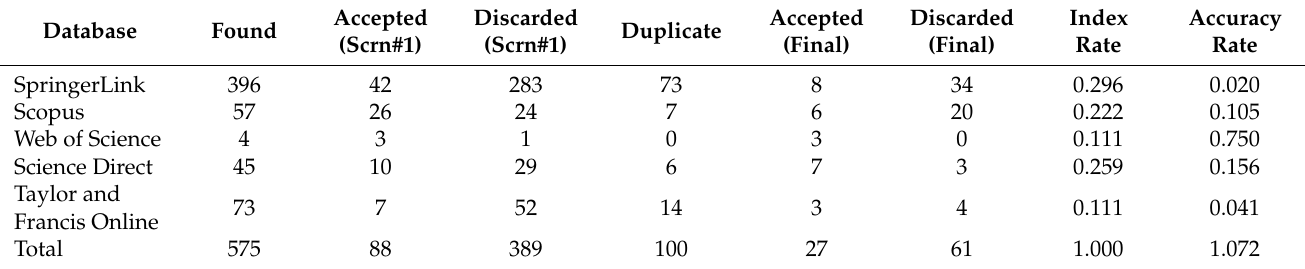
Table 2. The systematic review results in search sources for the accuracy rate of